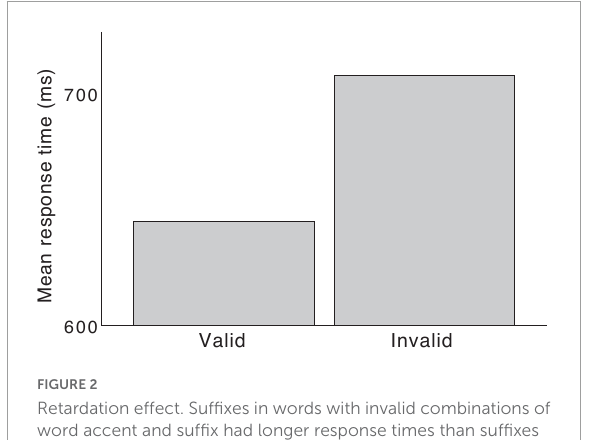
FIGURE3 Response time for valid words was the best predictor of the retardation effect for invalid words. A regression line with response time in valid words as the only predictor of the retardation effect is shown, R 2 = 0.093, F ( 1 , 75 ) = 7.69, p = 0.007.